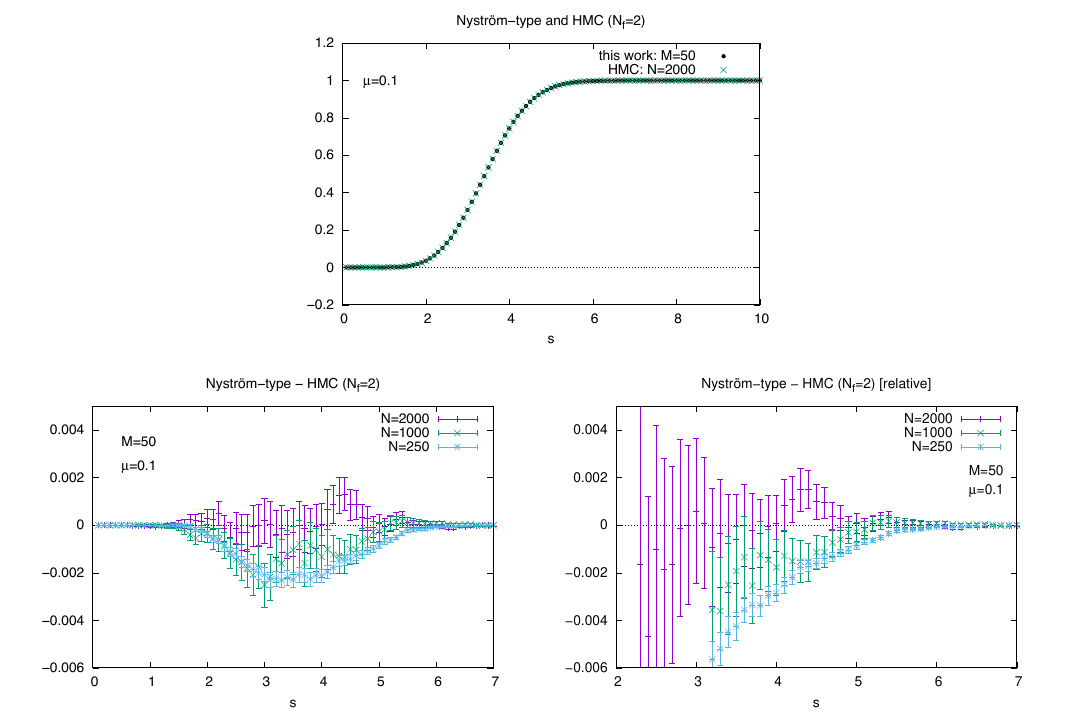
Figure 6 . The same plot as (cid:12)gure 3 but with doubly-degenerated masses (cid:22) 1 = 0 : 1 ( N F = 2) and the topological charge (cid:23) = 0. F 1 ( s ) for the (cid:12) = 4 ensemble is evaluated in two ways. Top panel: The Nystr(cid:127)om-type discretization is applied of order M = 50 (black dots) and the hybrid Monte Carlo simulation is applied with the random matrix rank N = 2000 (green cross), for which the statistical errors are smaller than the symbols and not shown in the plot. Bottom panels: Di(cid:11)erence between Nystr(cid:127)om-type discretization and hybrid Monte Carlo with several values of matrix rank N . F HMC ( s ) of the chiral random matrix ensemble (2.2) with the matrix rank N = 1000 is 1 depicted (green dots) in (cid:12)gure 6 as an